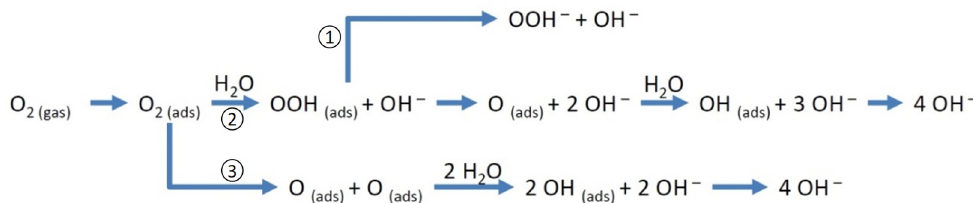
Figure 8. ORR scheme in alkaline solution (based on the scheme proposed in [28]).